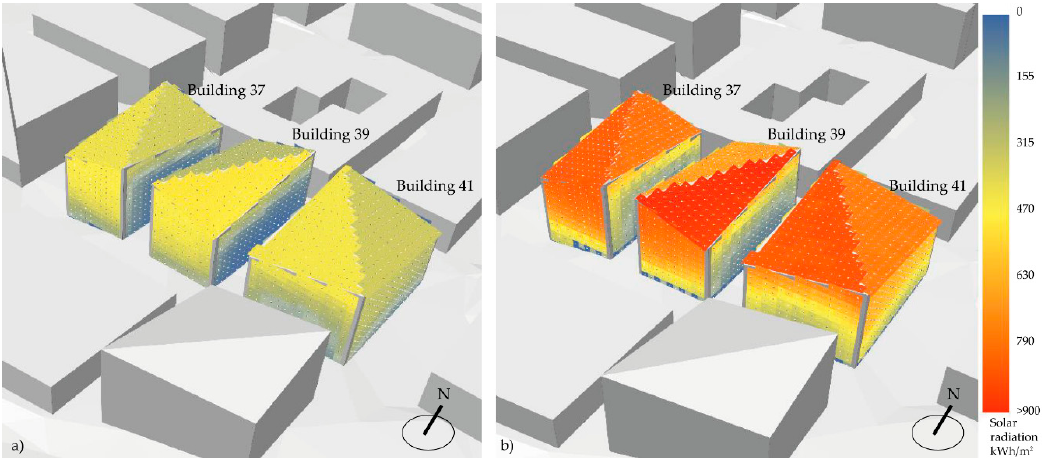
Figure 20. Annual analysis of direct solar irradiation ( a ) and global irradiation ( b ) in the critical area for feasibility study I.